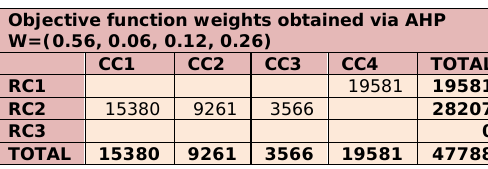
Table 7. Flows between collection centers and repair centers. Objective function weights via